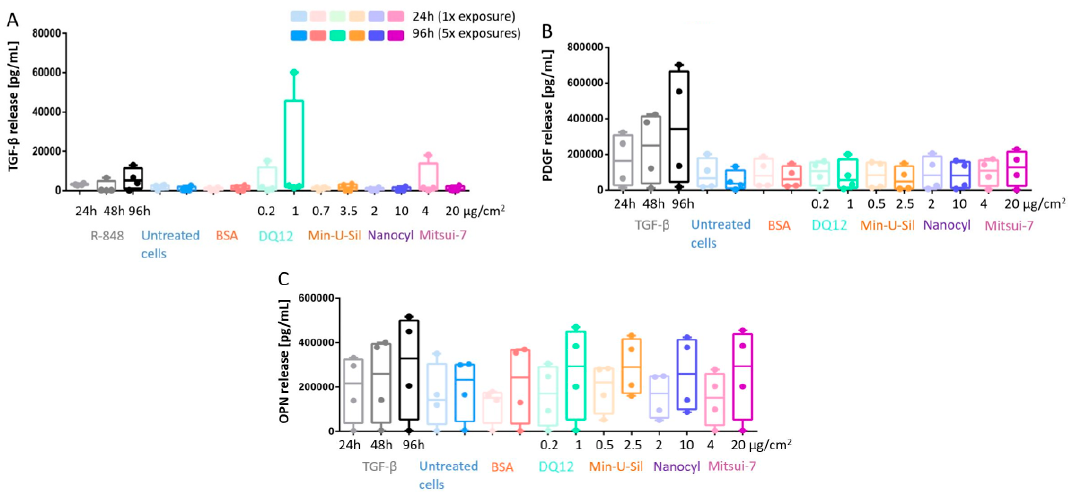
Figure 5. The profibrotic response measurements of the co-culture model. The responses were investigated via ( A ) TGF- β release; ( B ) PDGF release, and ( C ) OPN release. Data presented in a boxplot with 10–90 percentile. * marks a statistically significant increase compared to the negative control, n = 4.